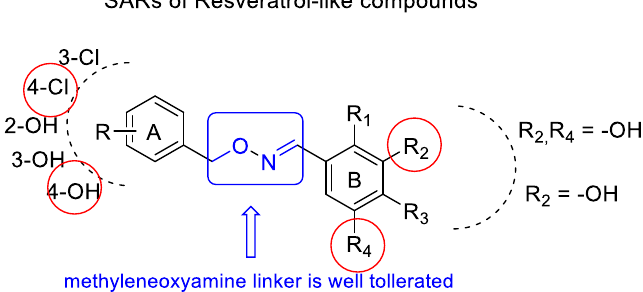
Figure 5. Graphic representation of SARs resveratrol-like compounds.